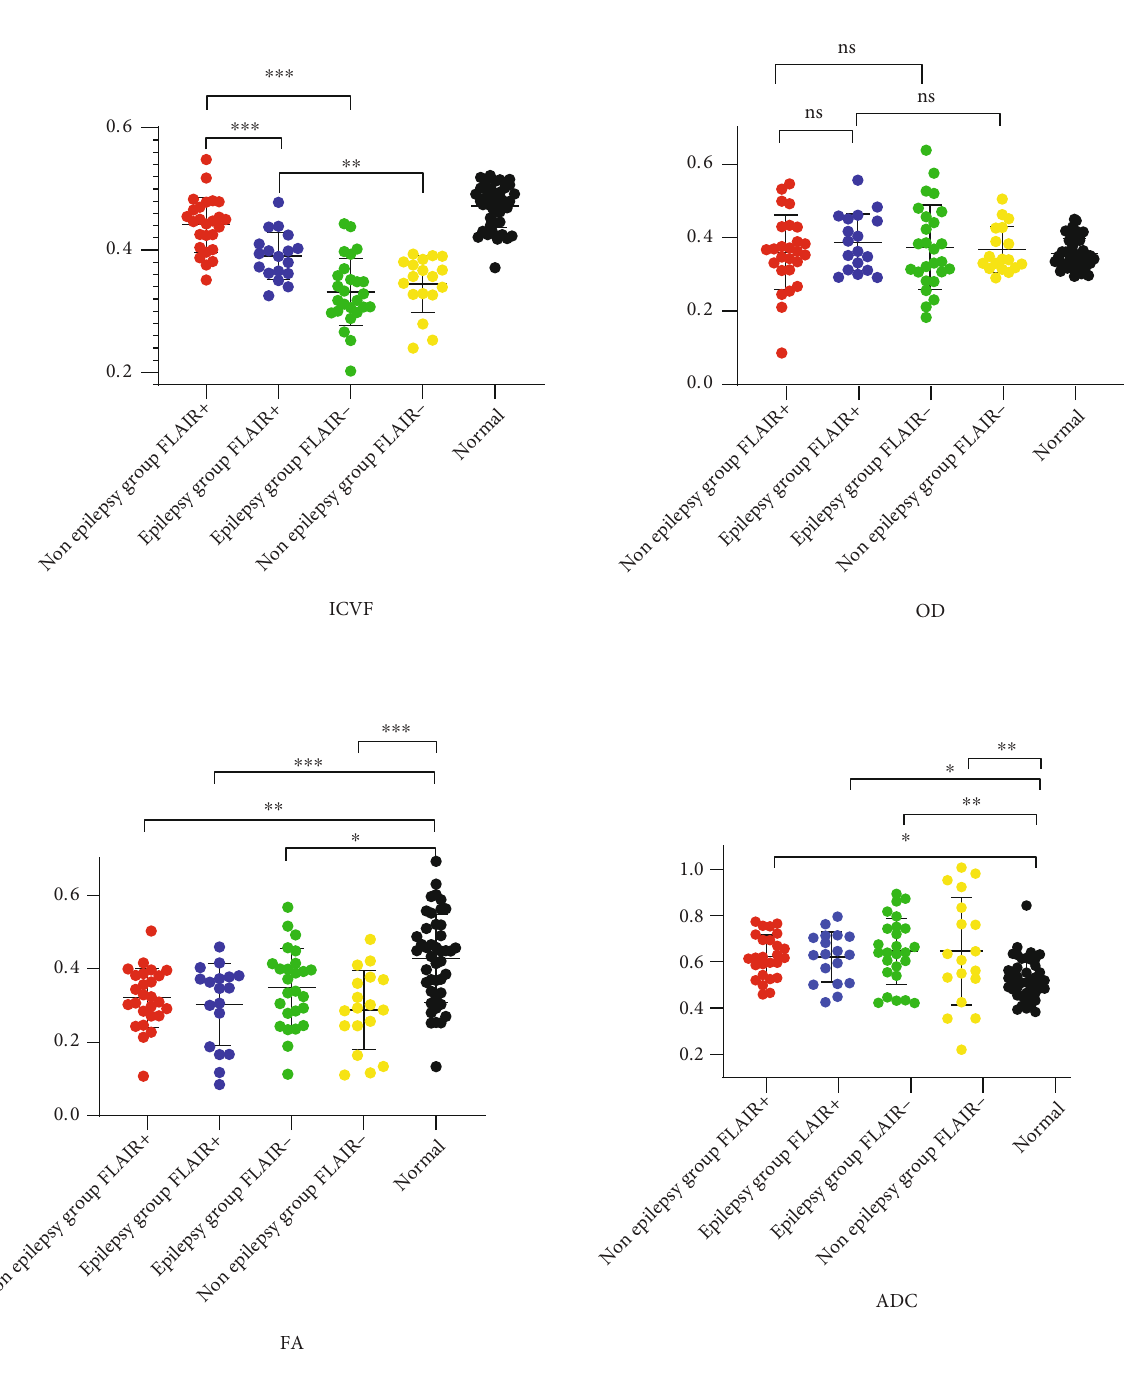
Figure 5: (a) ICVF. (b) OD. (c) FA. (d)